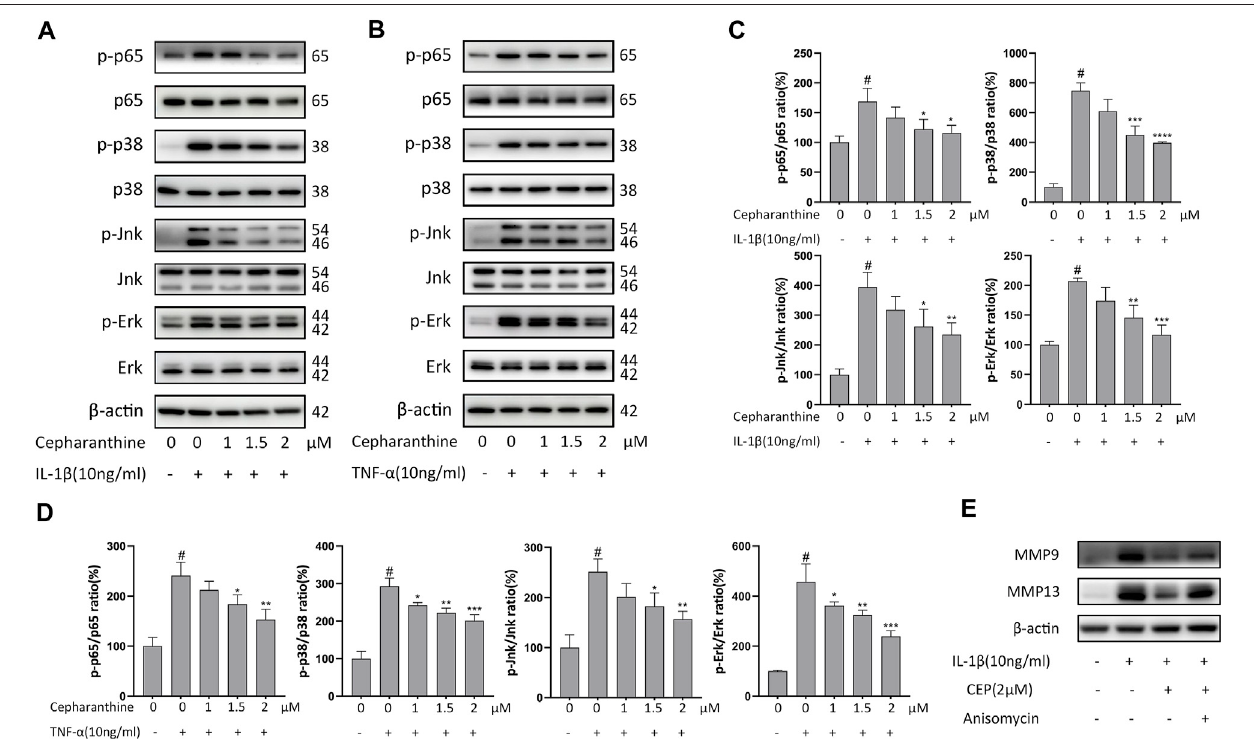
FIGURE 3 | CEP inhibited the activation of MAPK and NF- κ B signaling pathways induced by IL-1 β or TNF- α in chondrocytes. Chondrocytes were pretreated with variousconcentrationsofCEPfor2 handsubsequentlystimulatedwith10 ng/mlIL-1 β orTNF- α for30 min (A,B) Westernblotanalysisofp65,p-p65,p-38,p-p38, Erk, p-Erk, Jnk,and p-Jnkafter IL-1 β orTNF- α treatment. (C,D) Quantitativeanalysisrelevanttop-p65/p65,p-p38/p38,p-Jnk/Jnk,and p-Erk/Erk aftertreatmentwithIL-1 β orTNF- α ,respectively. (E) WesternblottingofMMP9andMMP13inchondrocytespretreatedwithorwithoutanisomycin(10 μ M)beforetreatmentwithCEP(2 μ M) or IL-1 β . Values are expressed as mean ± SD, n = 3; # p < 0.05 vs. control group, * p < 0.05, ** p < 0.01, *** p < 0.001, and **** p < 0.0001 vs. model